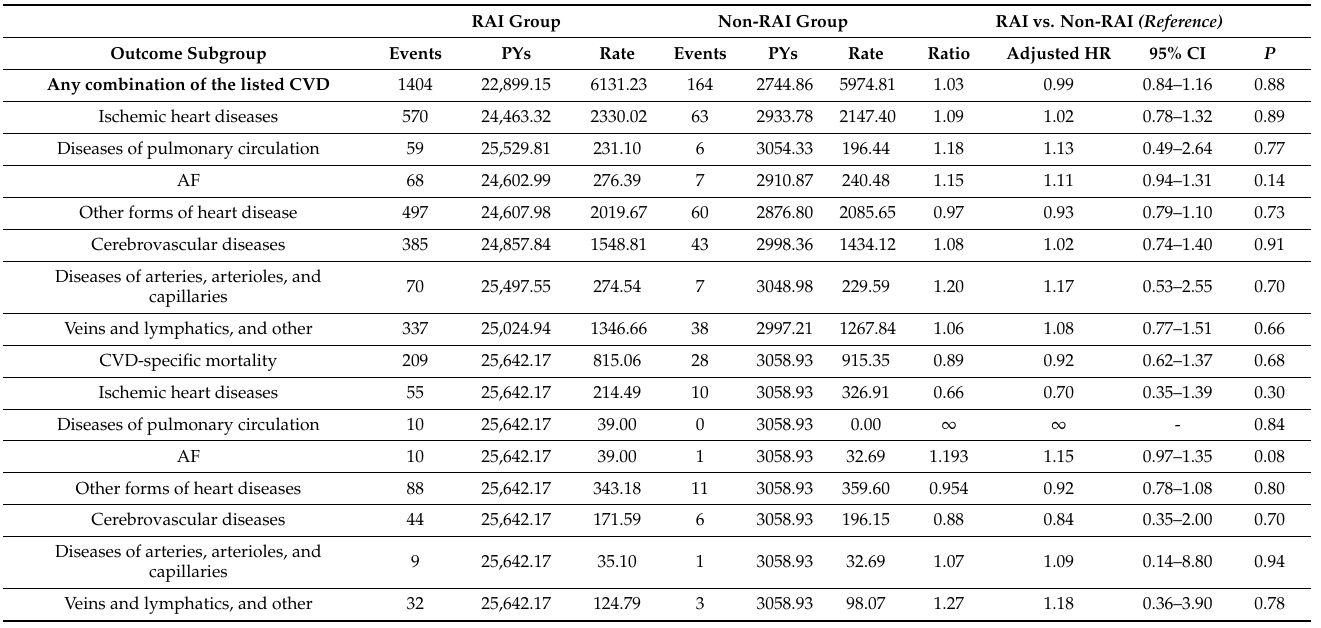
Table 4. Factors of CVD and CVD-specific mortality subgroup stratified by variables listed in the table by using Cox